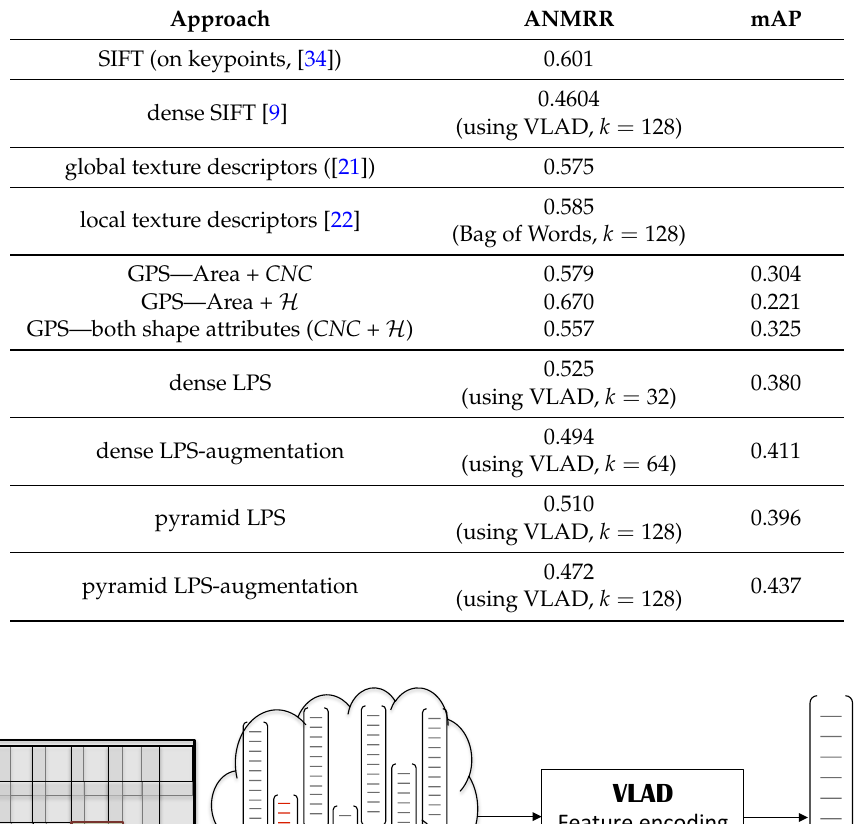
Table 1. The retrieval performances of different local and global approaches on Merced dataset.